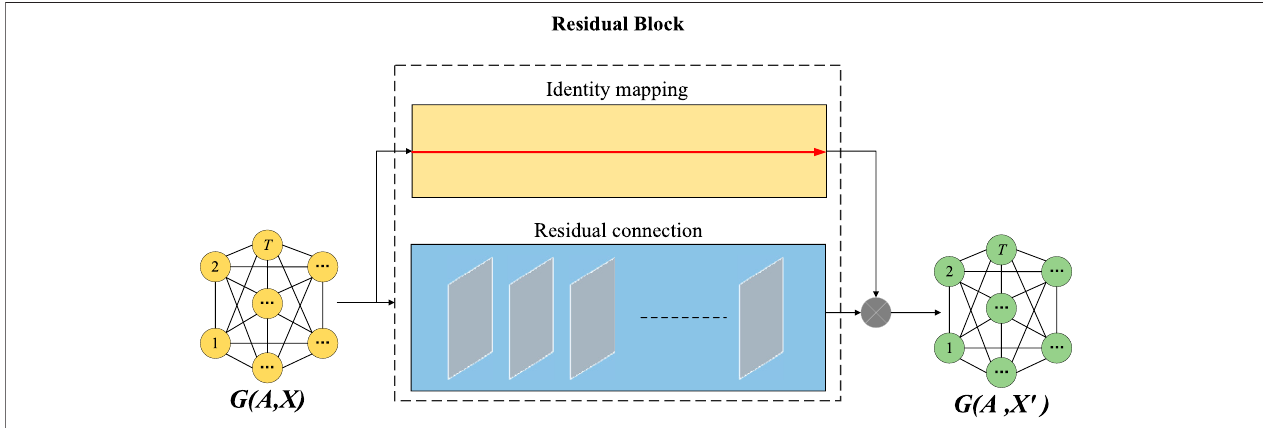
FIGURE 5 | Con fi guration of a ResGCN